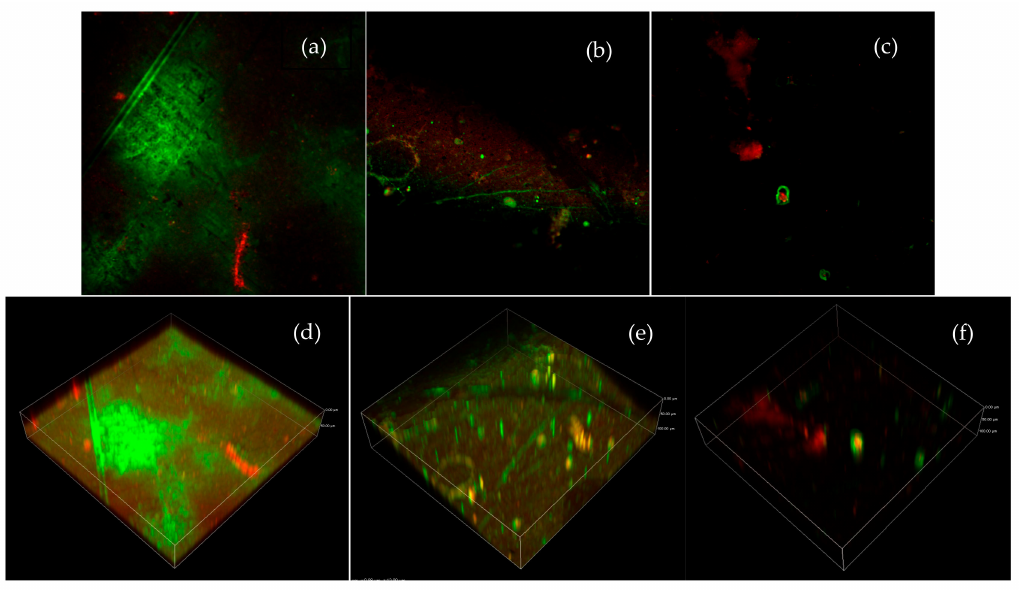
Figure 4. Confocal laser scanning microscope (CLSM) surface images of UF membranes; ( a ) UF 4 kDa